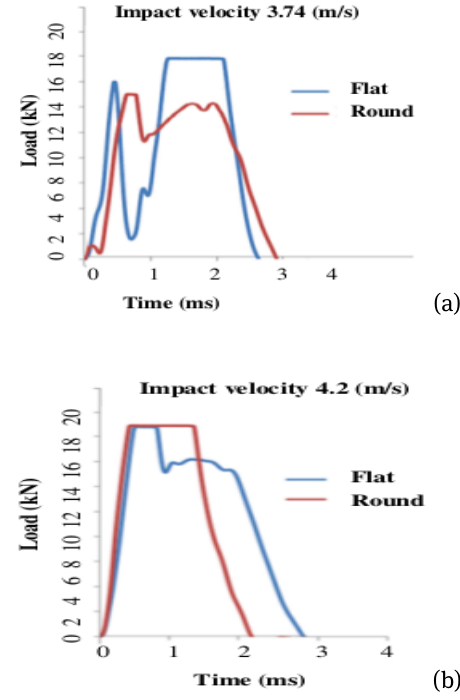
Figure 8: Load-time history of 24-Ply laminate under flat and round nose